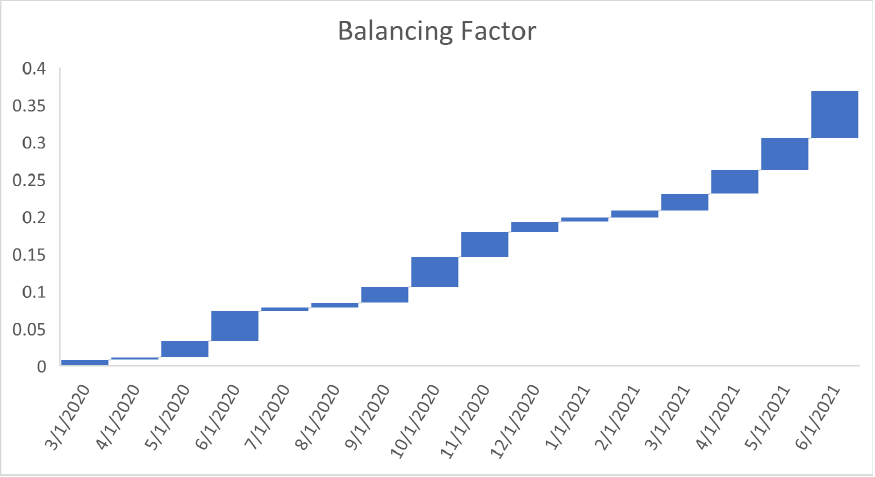
Figure 8. Progressive hyperparameter in US. For readability, note that 4/1/2020 refers 1 April 2020.